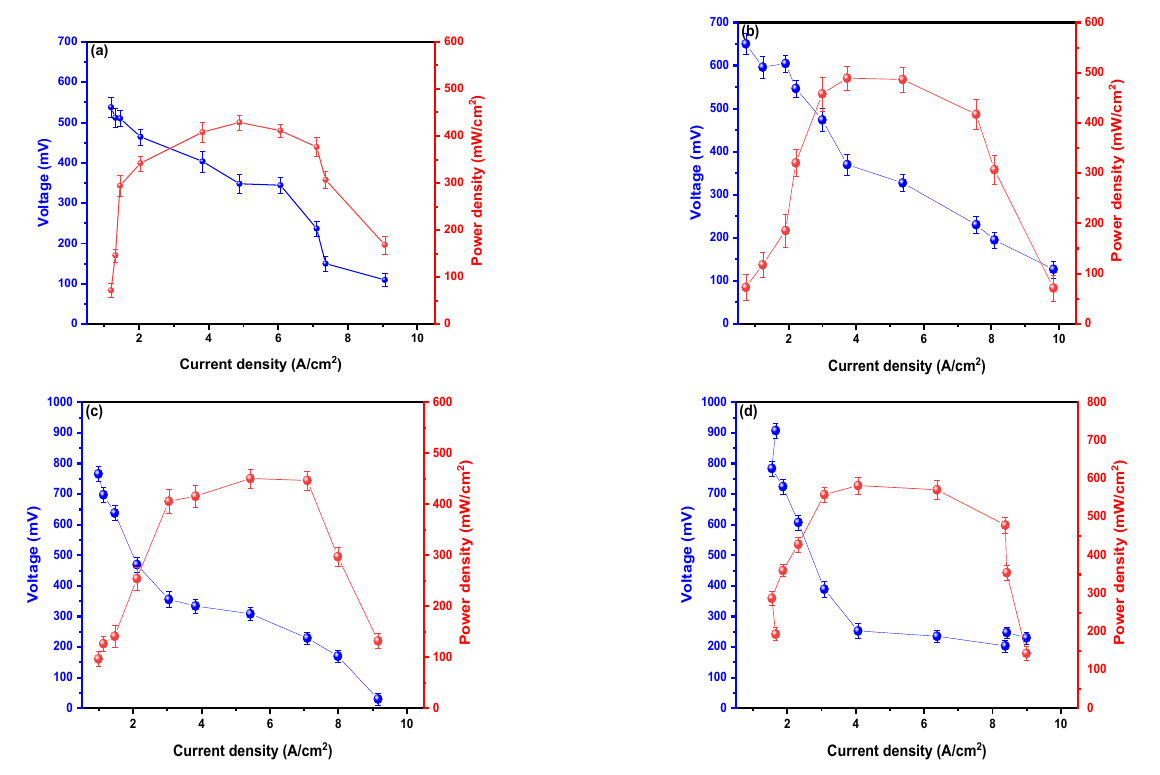
Figure 3. Values of the power densities as a function of the current density of the microbial fuel cells at ( a ) 0, ( b ) 5, ( c ) 10, and ( d ) 20% sucrose.